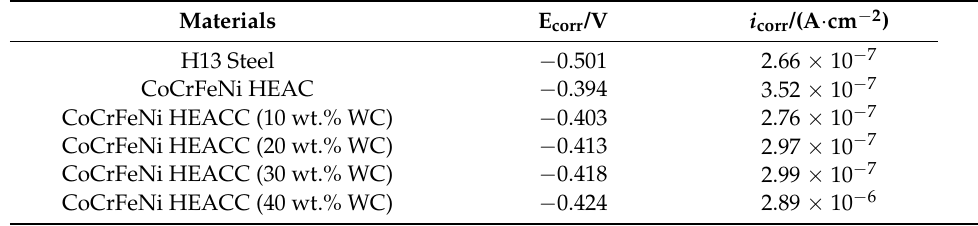
Table 5. Corrosion dynamics parameters for the